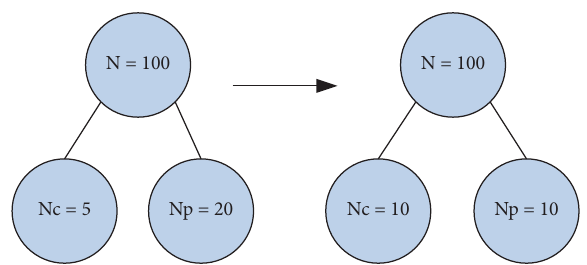
Figure 3: Te allocation of the number of groups Np and the number of coyotes in the group